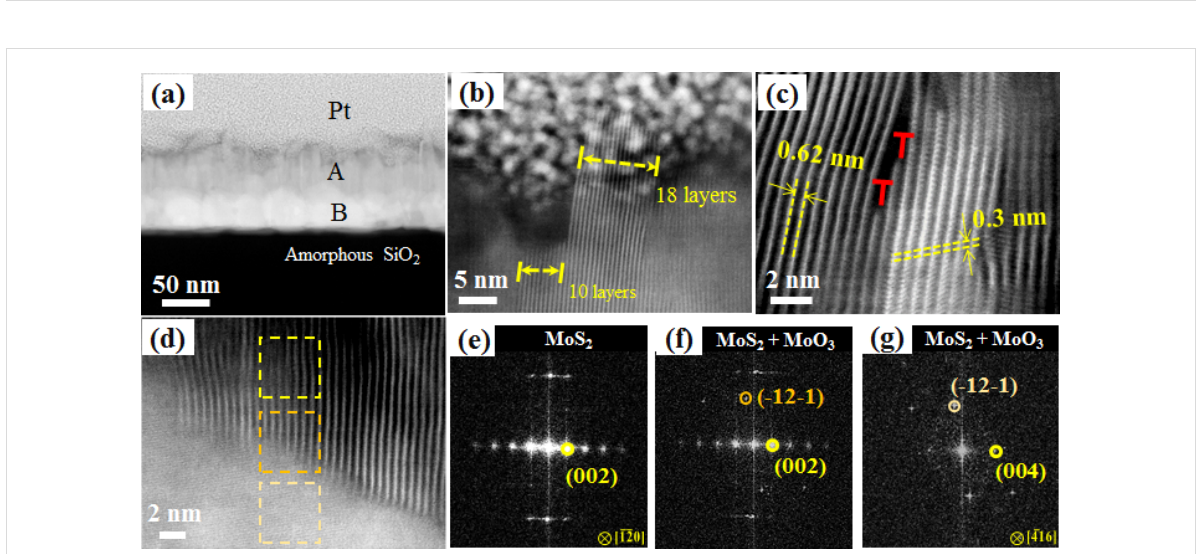
Figure 4: MoS 2 sample grown by double sulfurization of a 50 nm Mo film at 850 °C on SiO 2 /Si substrates: (a) HAADF-STEM image at low magnifica- tion with different observed materials layers marked; (b) TEM image at the interface between the MoS 2 NSs and the Pt layer; (c) higher magnification of layer A showing edge dislocation (marked with “T”) in the MoS 2 layers; (d) high-magnification HAADF-STEM image at the interface between “A” and “B” from panel (a); (e–g) FFT analysis over the area marked by the dotted squares in panel (d), from top to bottom respectively.